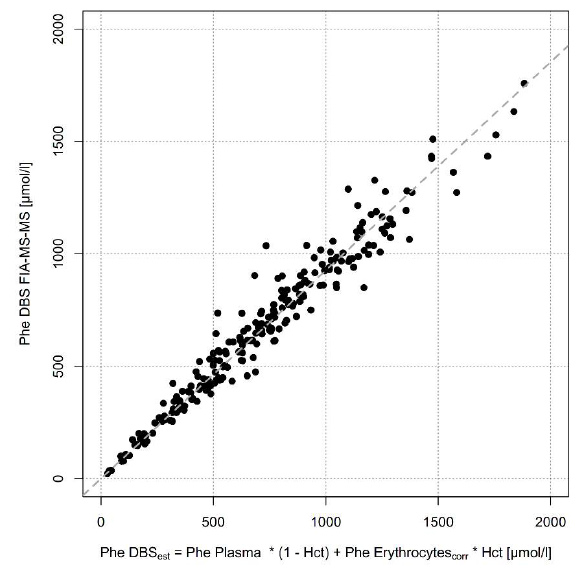
Figure 4. Association between estimated Phe concentrations in DBS using the formula Phe DBS est = Phe Plasma ∗ (1 − Hct) + Phe Erythrocytes corr ∗ Hct and Phe concentrations in DBS measured by FIA- MS-MS (n = 228). Dashed line: linear regression line.